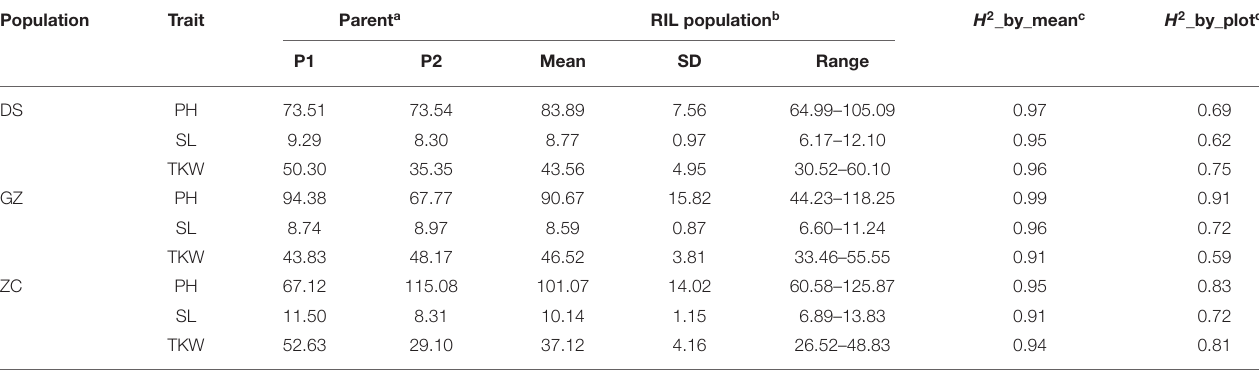
TABLE 1 | Mean performance and heritability of plant height (PH), spike length (SL), and thousand-kernel weight (TKW) in the three RIL populations, Doumai × Shi 4185 (DS), Gaocheng 8901 × Zhoumai 16 (GZ), and Zhou 8425B × Chinese Spring (ZC), across multiple environments.